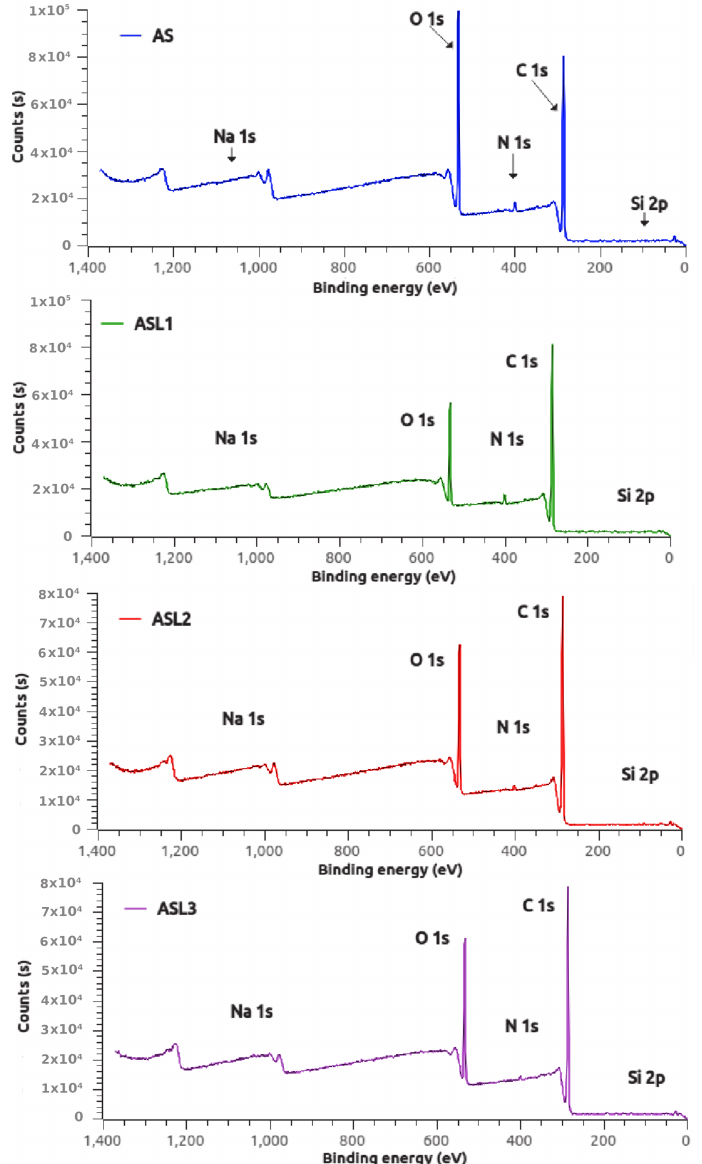
Figure 2. X-ray photoelectron spectroscopy of native (AS) and modified amaranth starches (ASL1, ASL2 and